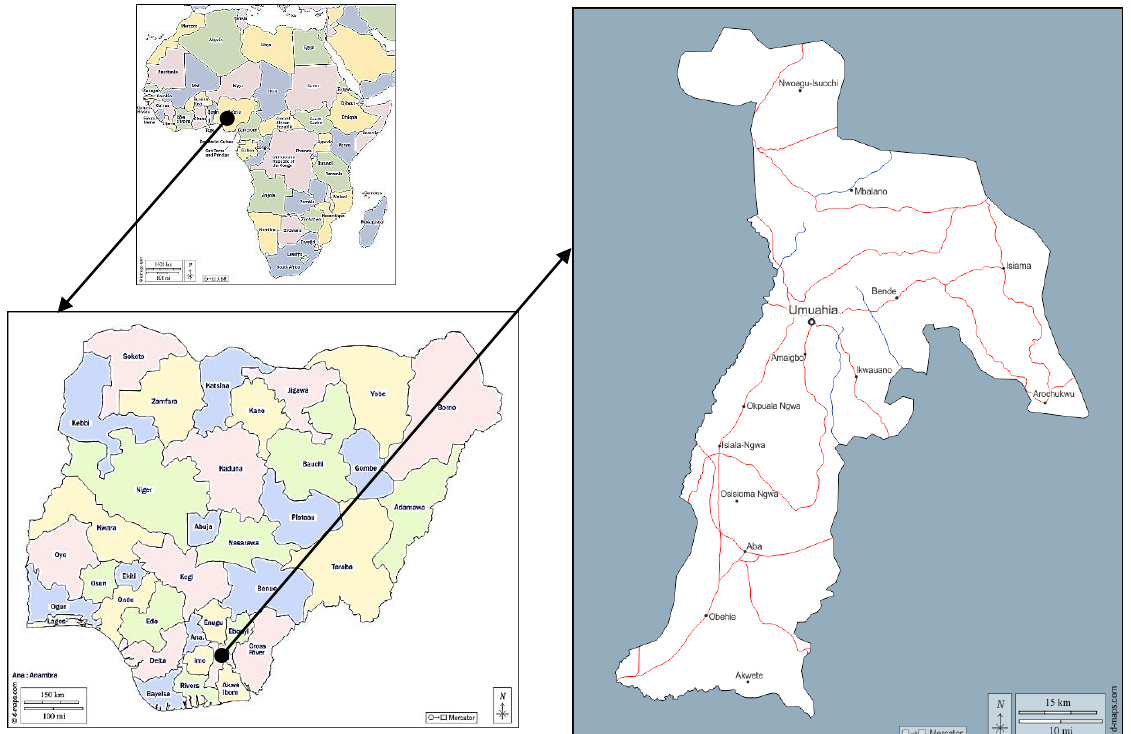
Figure 1. The Location of data collection in Umuahia North, local government area of Umuahia, Abia State,